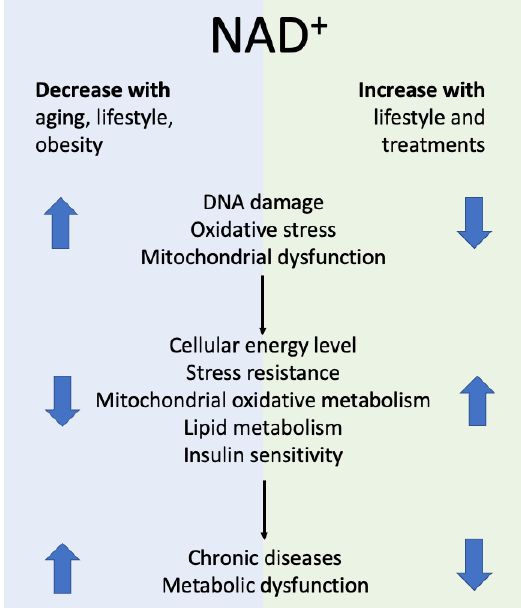
Figure 2. Association of NAD+ bioavailability and healthspan.